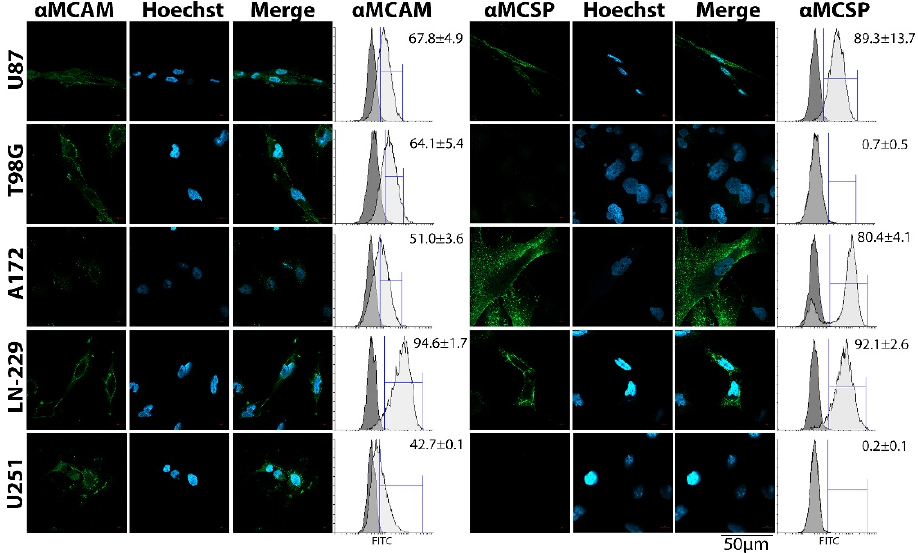
Figure 1. Melanoma cell adhesion molecule (MCAM) and MCSP on glioblastoma (GBM) cells. Cell surface expression of MCAM (left) and MCSP (right) was screened on the indicated cell lines by immunocytostaining (specific protein detected in green FITC channel, while Hoechst staining detects cell nuclei, merged images included) and flow cytometry. Proportions of cell populations expressing the indicated protein are stated from at least n = 2 independent experiments (as gated on flowcytometry data comparing the light grey protein-specific peak to isotype-matched IgG probing (dark grey peak)). Representative histograms included.